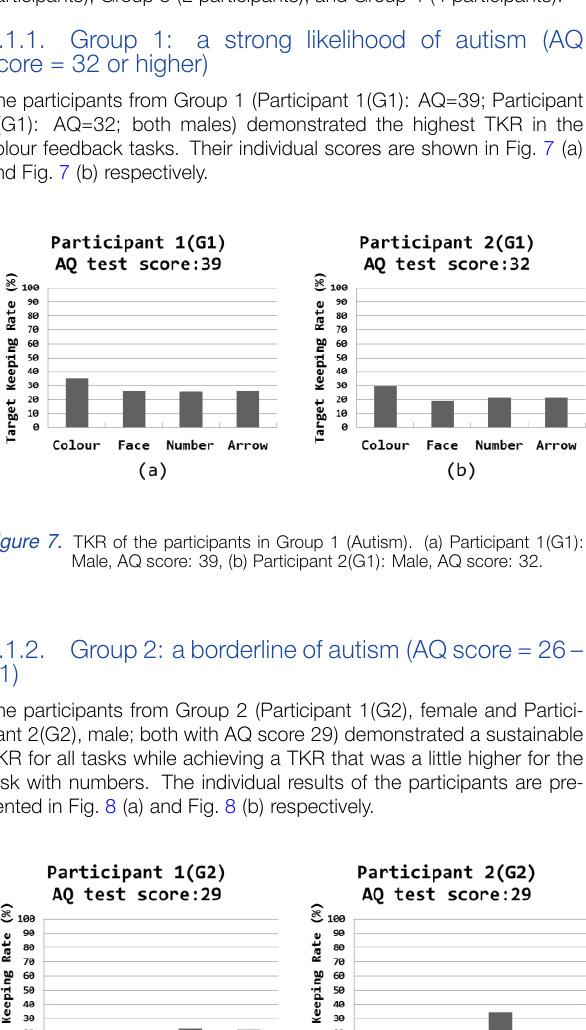
Figure 8. TKR of the participants in Group 2 (Borderline). (a) Participant 1(G2), female, AQ score: 29; (b) Participant 2(G2), Male, AQ score: 29.